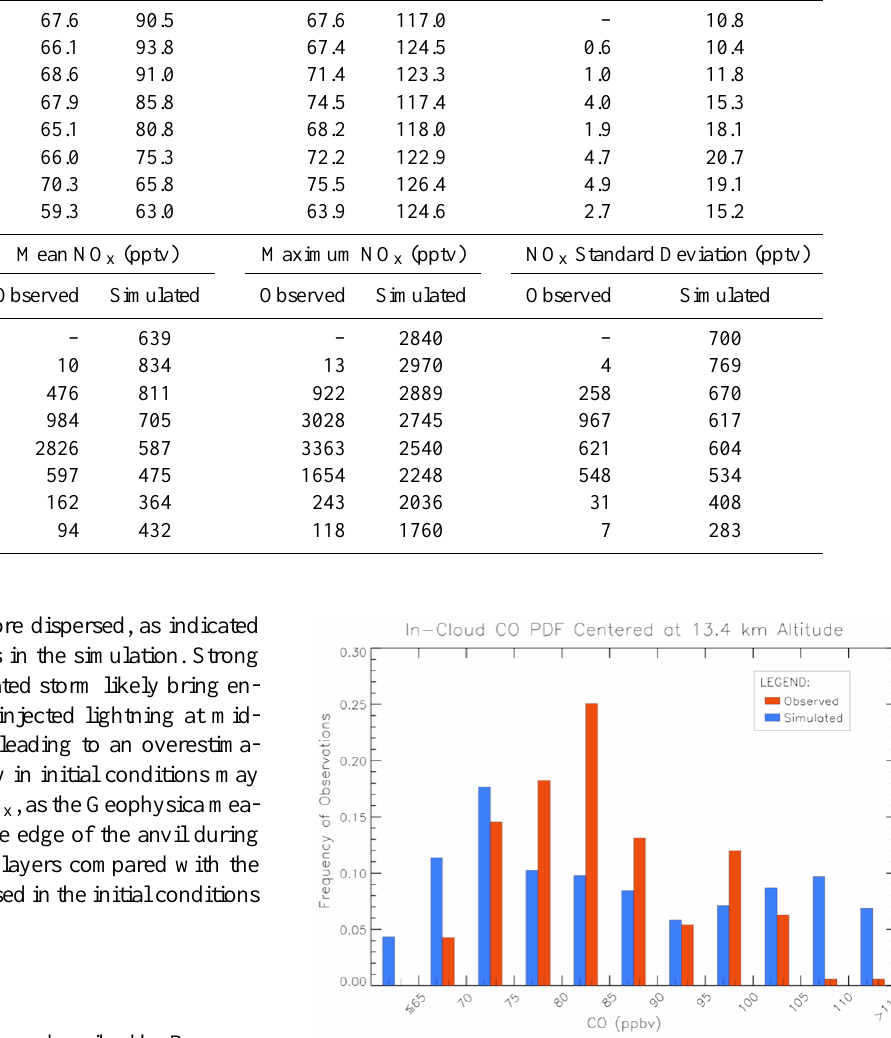
tics of the cloud. The largest mean partial NO 2 column values ( ≥ 60 × 10 14 molecules cm − 2 ) are located along and just south of Apsley Strait. Low-level radar reflectivity in- dicate Hector is on the western coast of Bathurst Island prior to 14:45 LT (Fig. 7). With northerly upper level winds (Fig. 3) and a westward motion of the storm track across the Tiwi Islands, NO 2 is transported away from the storm core and along the anvil, explaining the placement of the large mean NO 2 column values. However, the Ozone